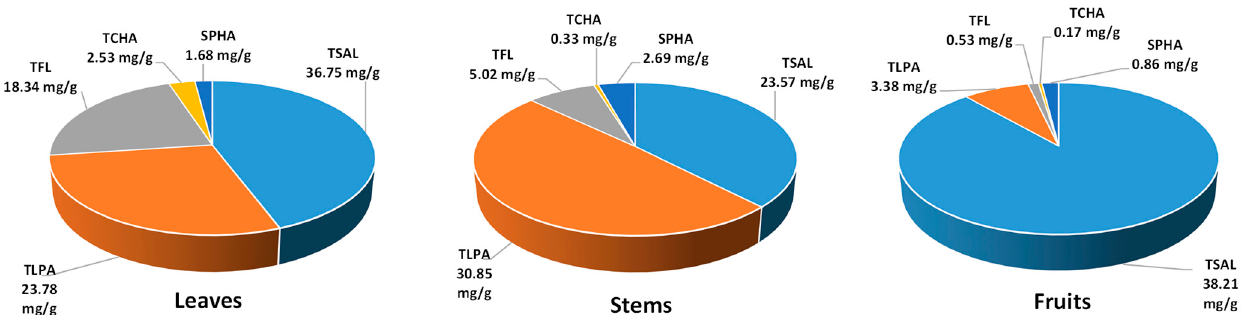
Figure 5. Recovery of polyphenols from the G. procumbens leaves, stems, and fruits with methanol– water (75:25, v / v ) extracts. TSAL: total content of salicylates; TLPA: total content of proanthocyanidins; TFL: total content of flavonoids; TCHA: total content of chlorogenic acid isomers; SPHA: total content of simple hydroxybenzoic and hydroxycinnamic acids. Results expressed per dw of the plant material. Values for the stem and fruit extracts were recalculated from the previously published original data [8,9].